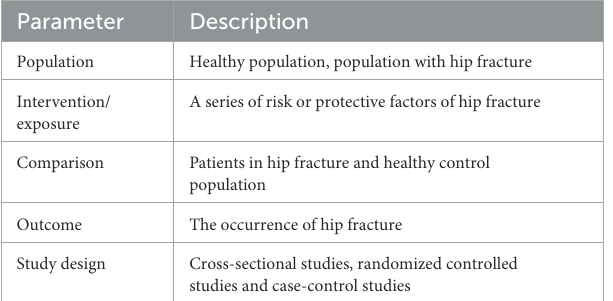
TABLE 1 PICOS framework of the study for the identification of related factors of hip